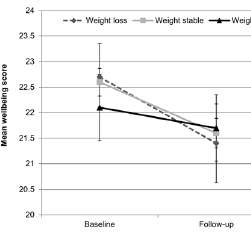
Figure 5. Prevalence of high serum triglycerides at baseline and follow-up by weight change status. Values are mutually adjusted for age, sex, wealth, and weight loss intention. Error bars represent the 95% confidence interval.